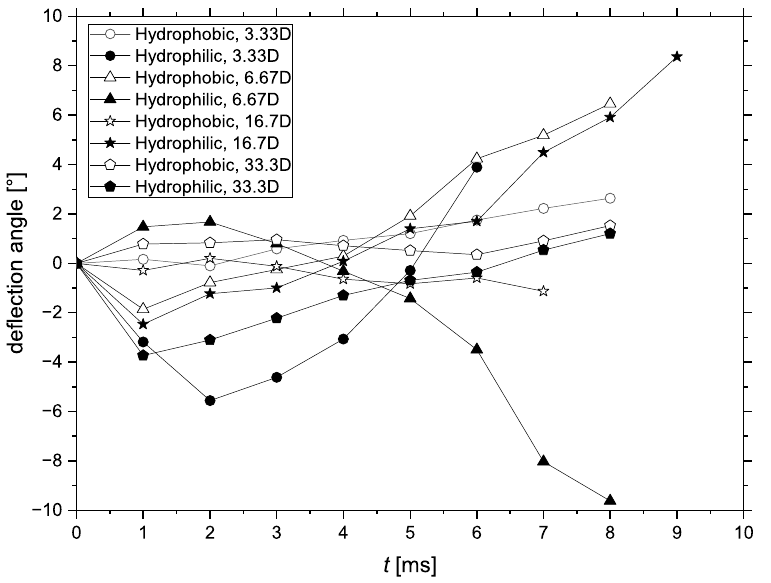
Figure 13. Variation in deflection angle of the projectile with time under different working